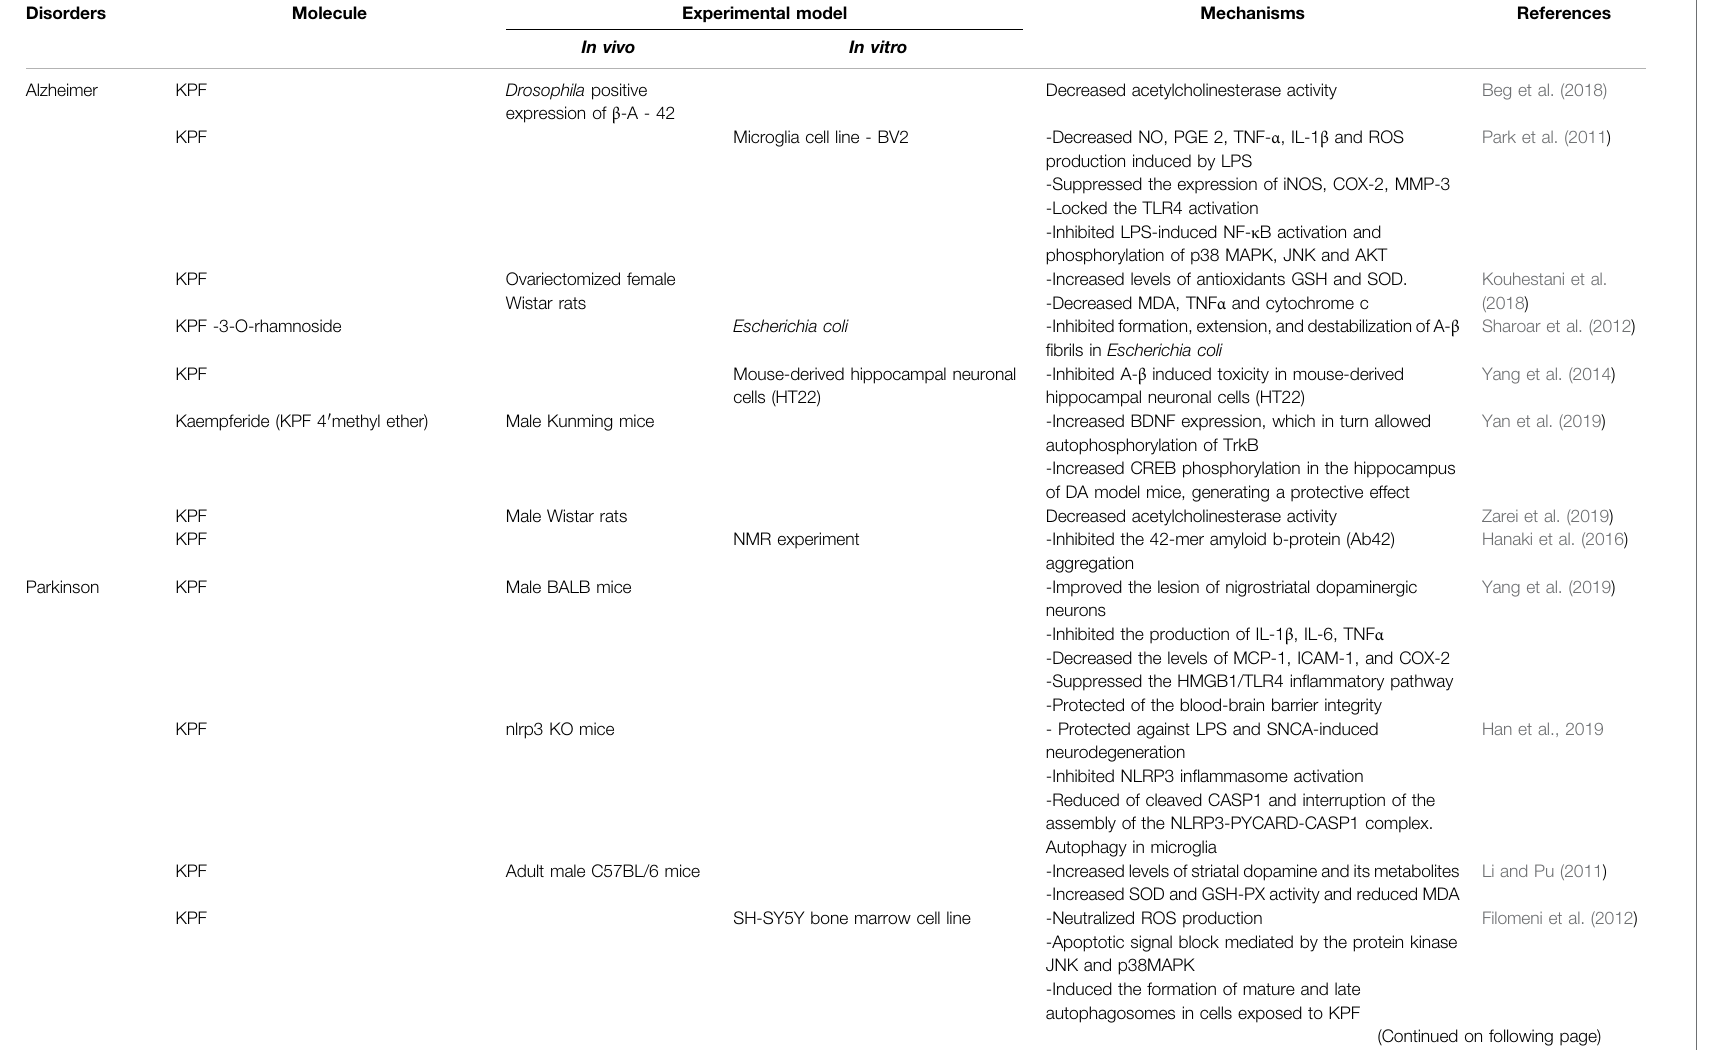
TABLE1| Summaryof invivo and invitro studiesconsideringtheactionofkaempferol(KPF)anditsderivativesinAlzheimer,Parkinson,ischemia,epilepsy,majordepressivedisorder,anxietydisorders,neuropathicpain,and